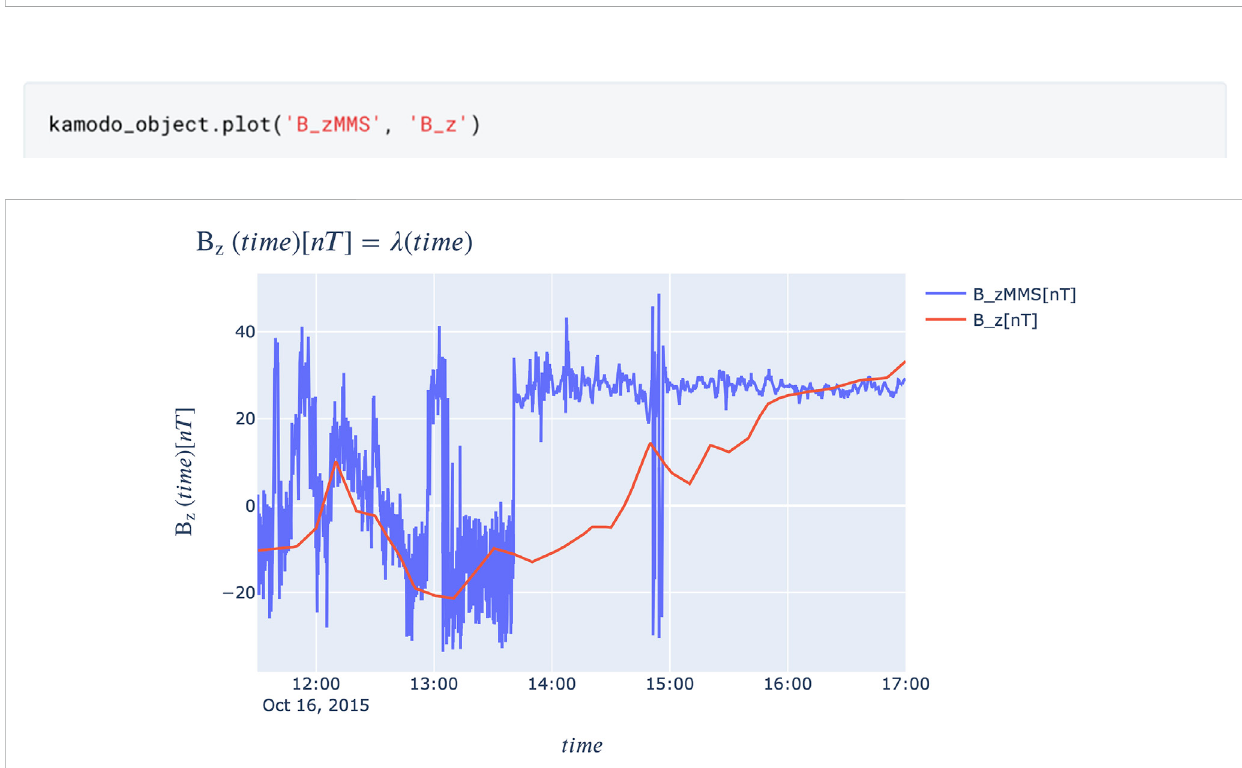
FIGURE 9 Time series plot of the observed B_z magnetic fi eld component (blue) with the modeled one (red).